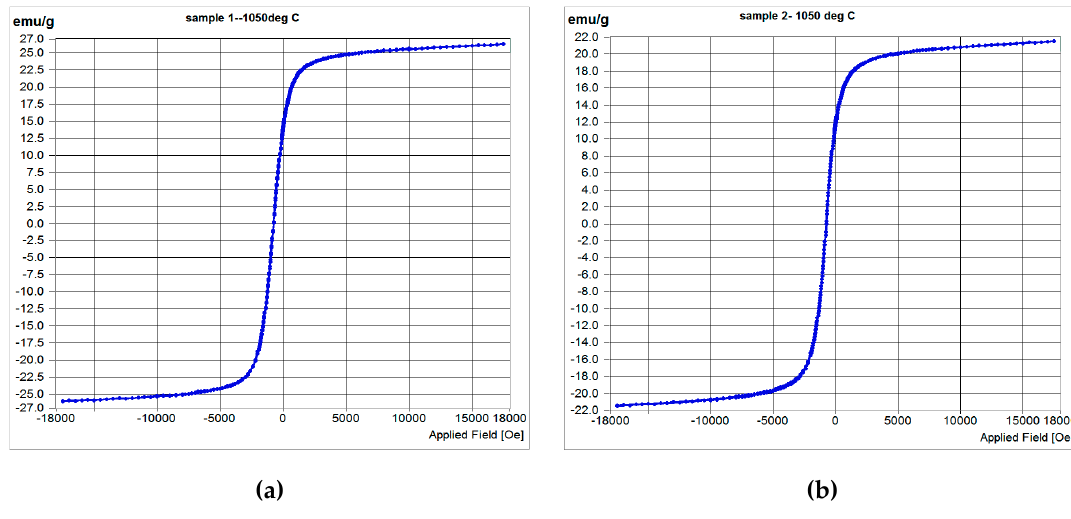
Figure 15. XRD patterns of S1050b4, S1050a3, S950b4, and S950b3. Table 7. Magnetic parameters of samples S1050b4 and S1050b3.